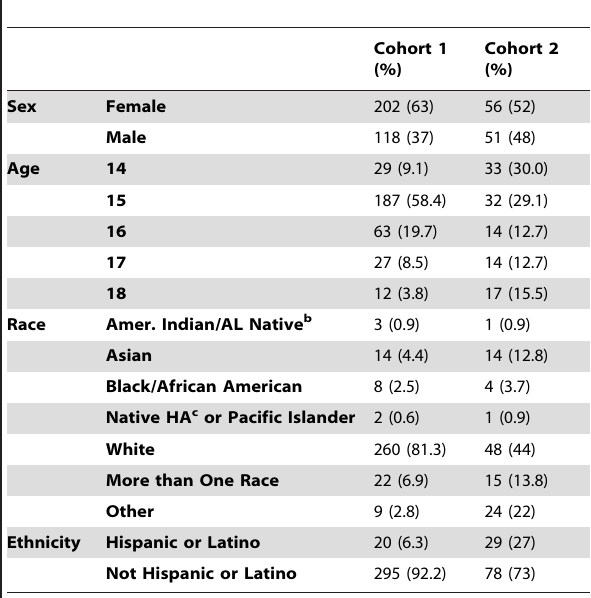
Table 3. Demographic Characteristics of Cohort 1 (CURE Treatment) and Cohort 2 (Comparison) Students a .